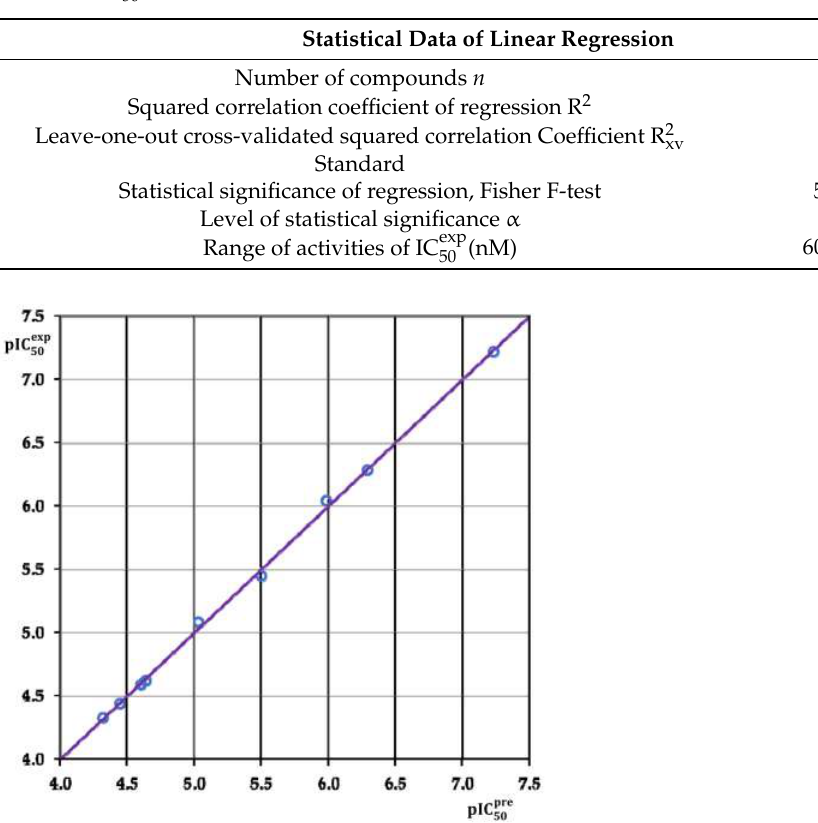
) against FP3. pIC exp 50